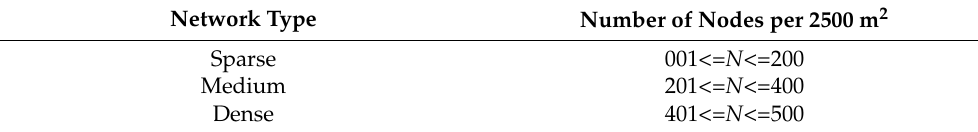
Table 4. Categorization of nodes for density.